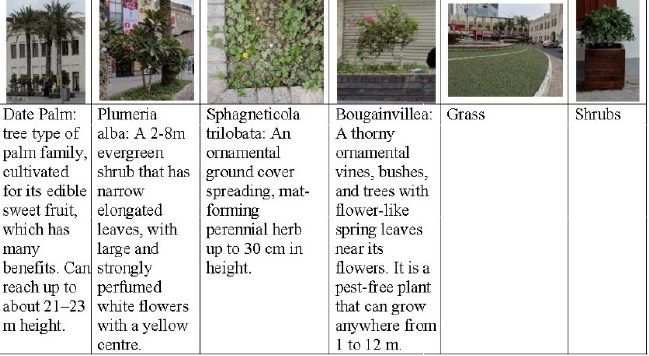
Figure 18. species of the plants that are in Bab Al Bahrain Avenue.